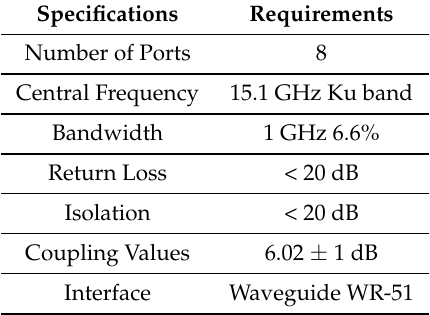
Table 1. General electrical specifications of the eight-port